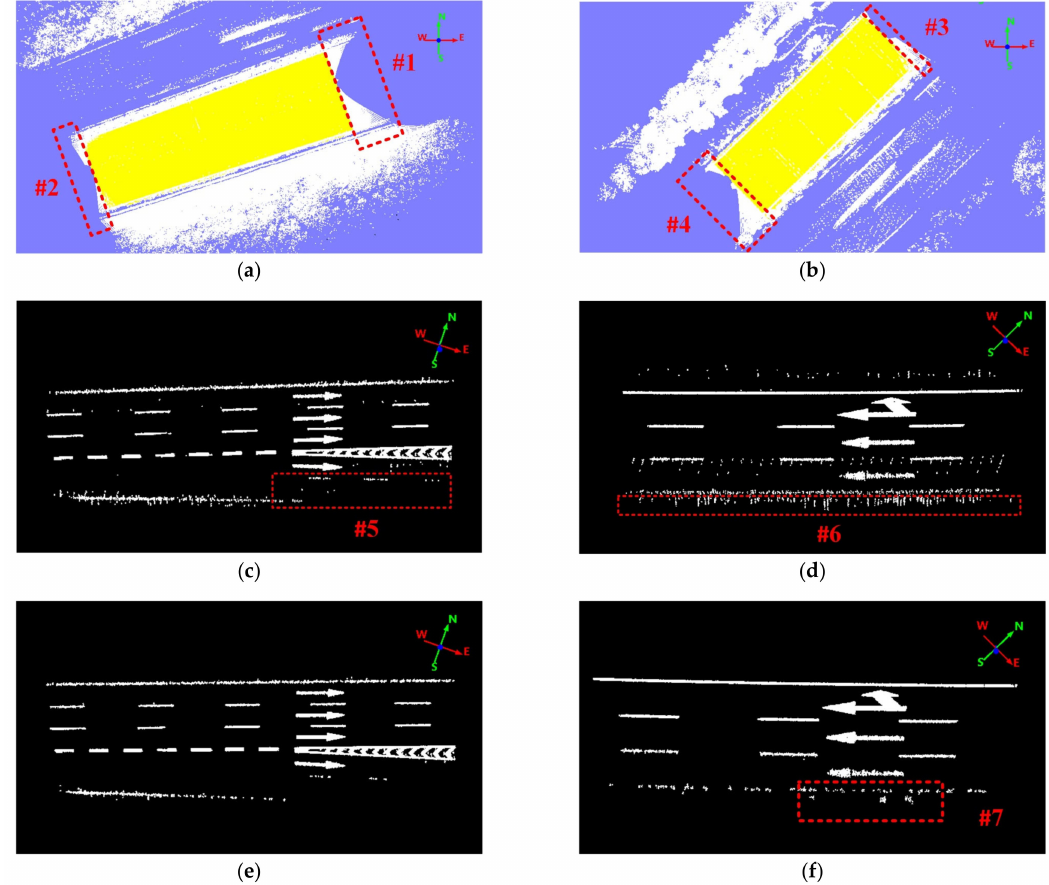
Figure 7. Extraction results of the two datasets: ( a , b ) Extracted road surfaces; ( c , d ) extracted road markings; ( e , f ) refined road